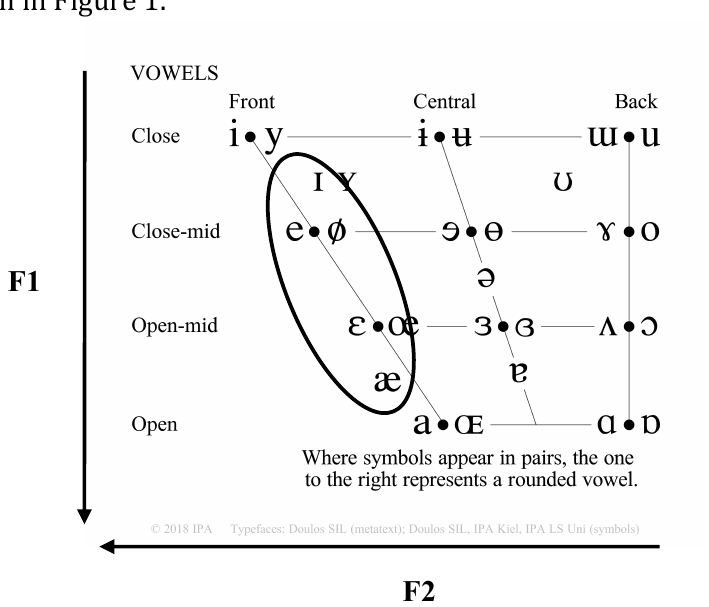
Figure 1: Vowel diagram of the International Phonetic